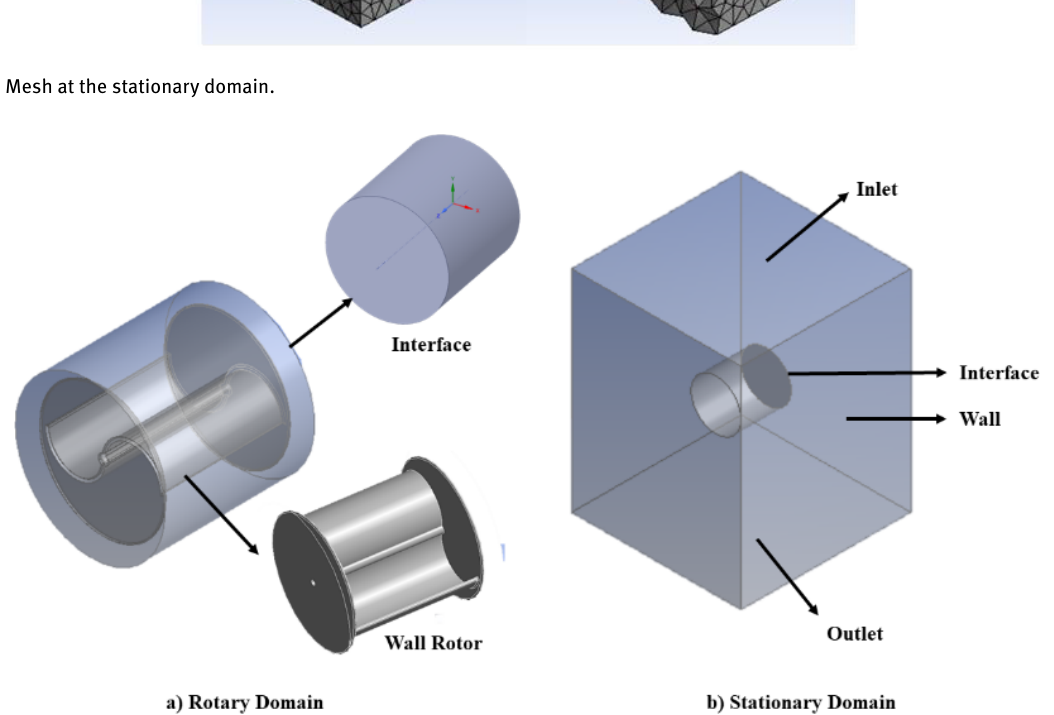
Figure 7: Domain of